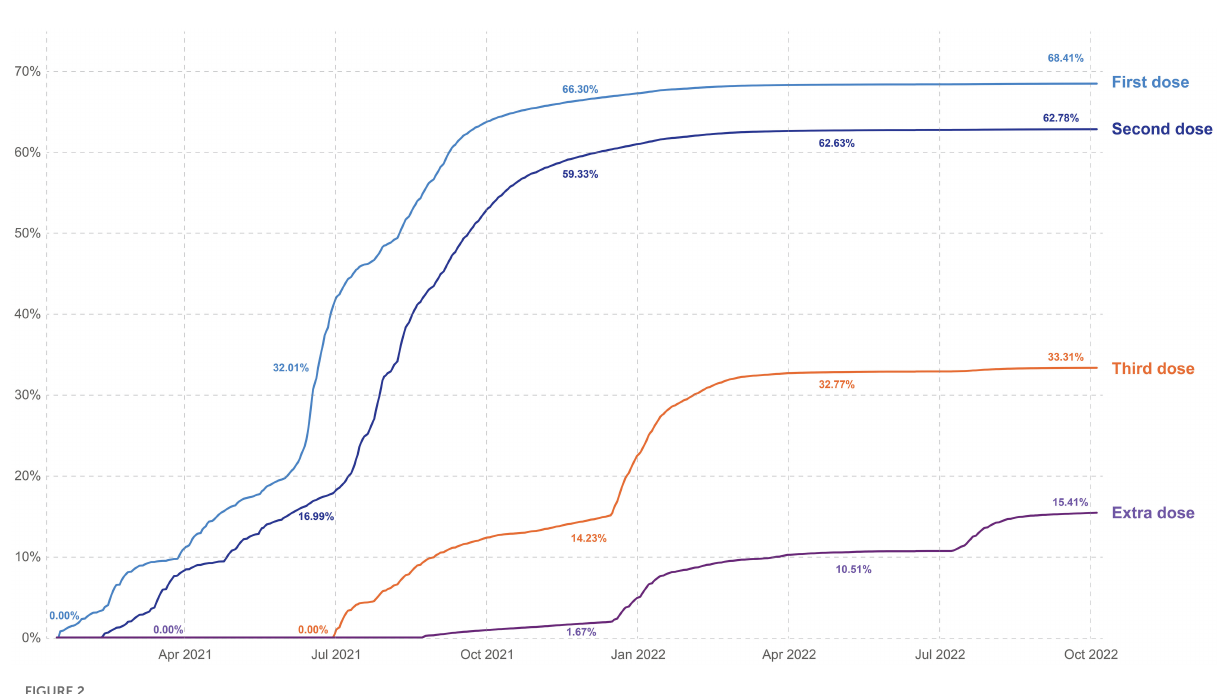
FIGURE3 COVID-19 vaccination by month (graphic Zeki Berk, Türkiye).